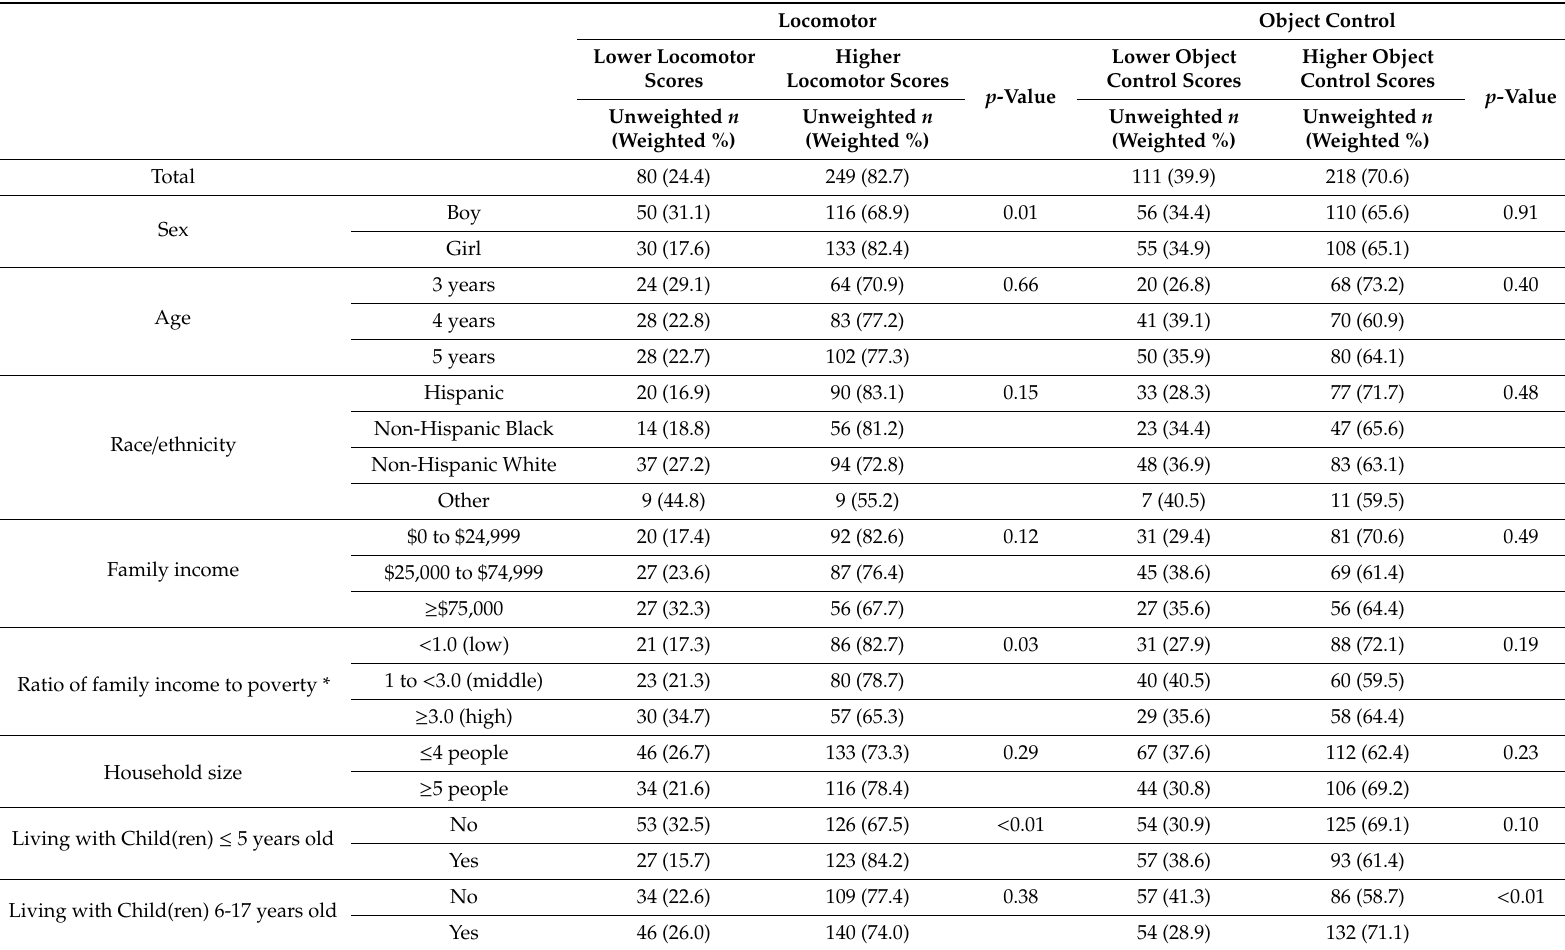
Table 4. Bivariate analyses between participant characteristics and locomotor and object control